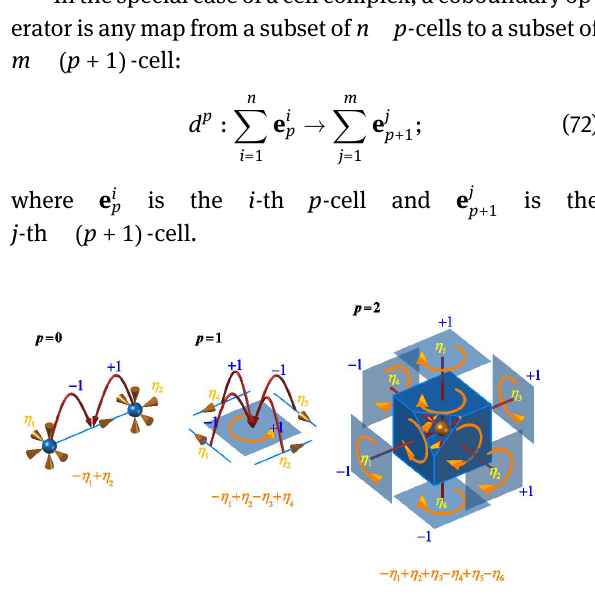
Figure 59: How to find the weight of a ( p + 1) -cell starting from the weights of its